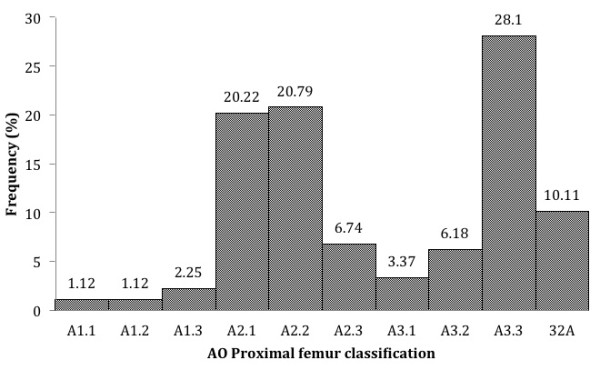
AO/ASIF classification.